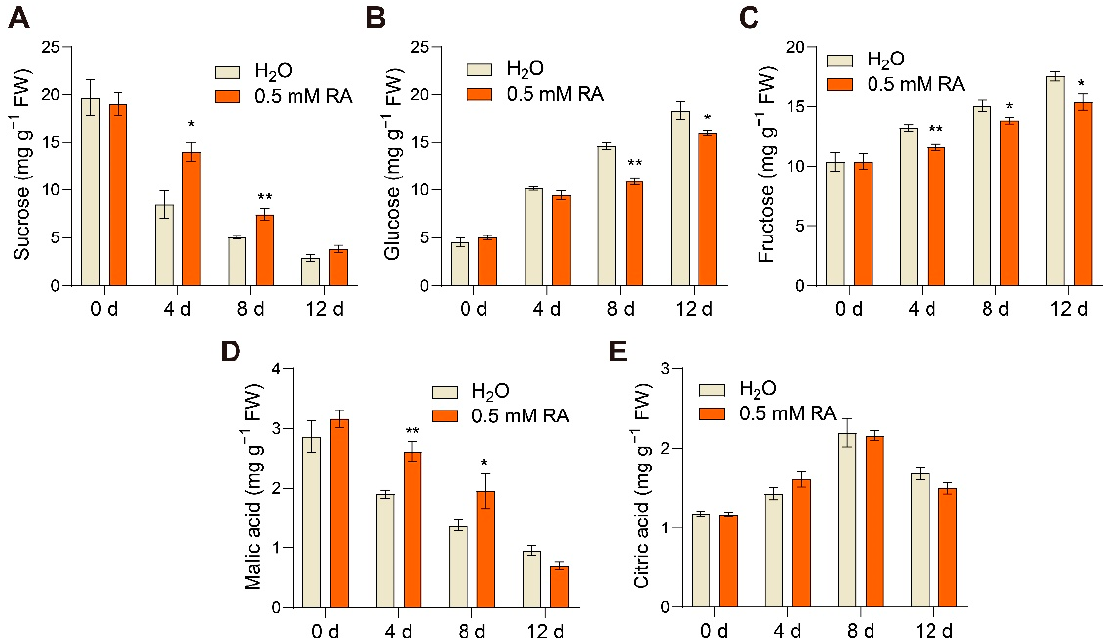
Figure 4. RA influenced sugar and organic acid accumulation during fruit ripening. Effects of RA treatment on ( A ) sucrose content, ( B ) glucose content, ( C ) fructose content, ( D ) malic acid content, and ( E ) citric acid content. Tomato fruits at the mature green stage were treated with 0.5 mM RA, or H 2 O control. The fruit samples were collected at the indicated time points for sugar and organic acid content quantification. The data are presented as mean values ± SD; n = 3. Asterisks indicate statistically significant differences (* p ≤ 0.05, ** p ≤ 0.01) compared with control under the same time point, as determined by Student’s t -test.